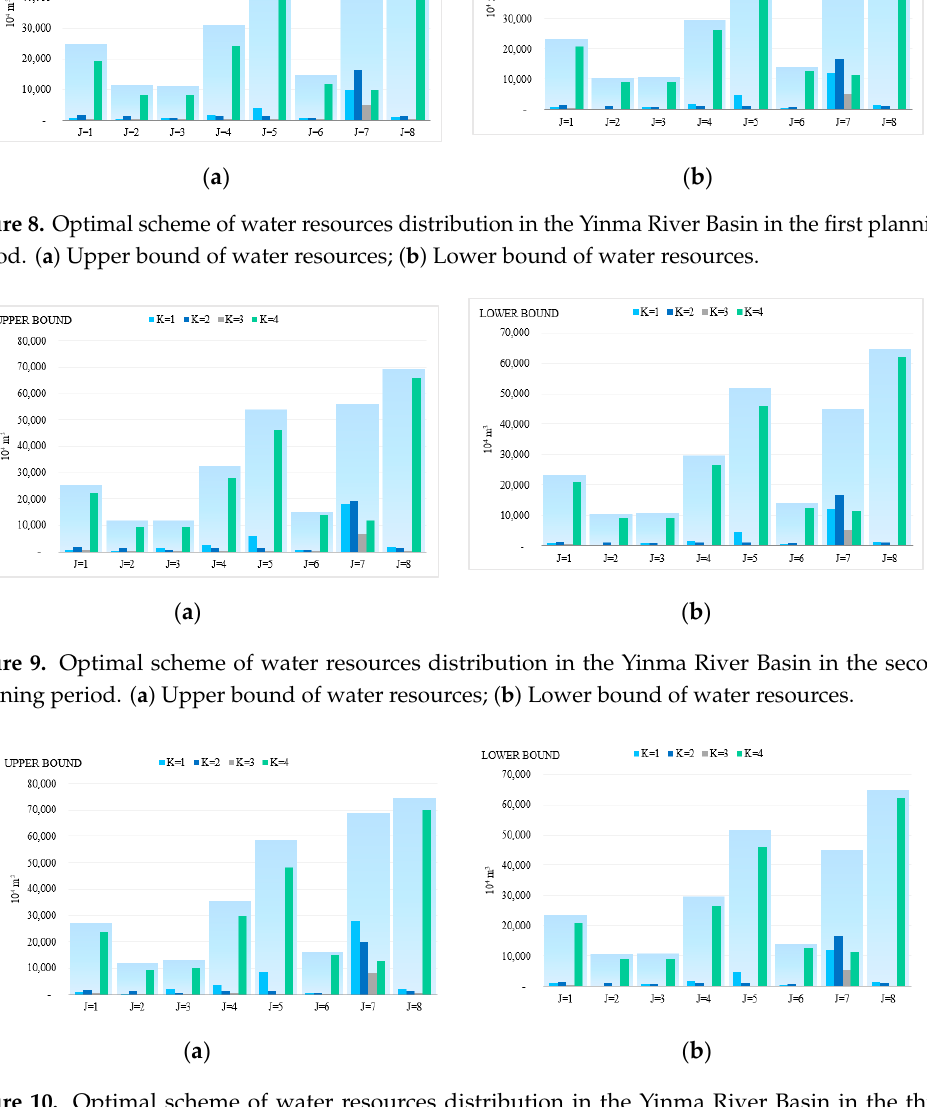
Figure 10. Optimal scheme of water resources distribution in the Yinma River Basin in the third planning period. ( a ) Upper bound of water resources; ( b ) Lower bound of water resources.